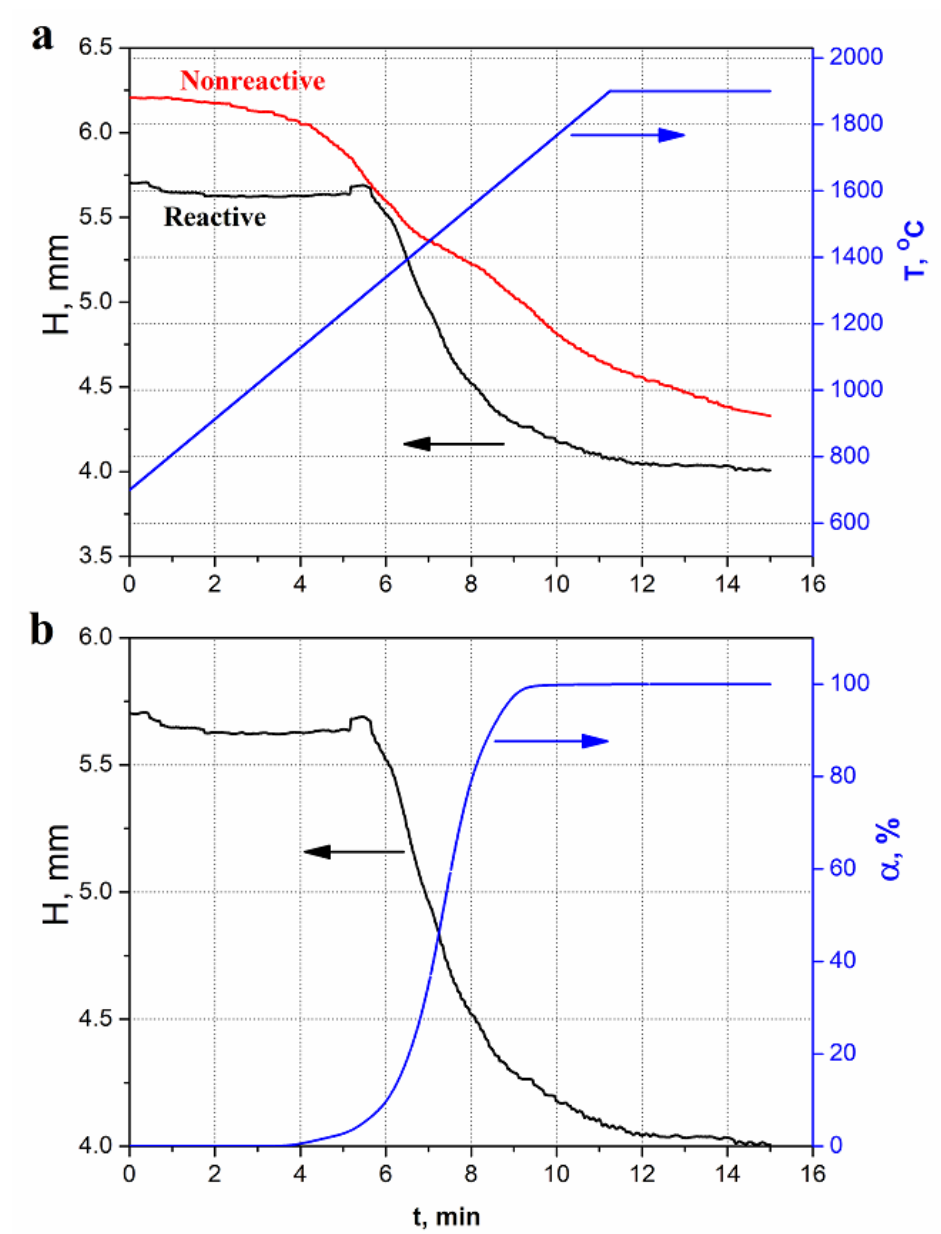
Figure 3. The sample heights (H) (thickness) evolution during hot pressing of the “reactive” (reaction (2) precursor stoichiometry) and “non-reactive” (reaction (2) products) powder mixtures (Table 1) alongside the process temperature ( a ), and the degree of conversion ( b ) for the reactive sample.